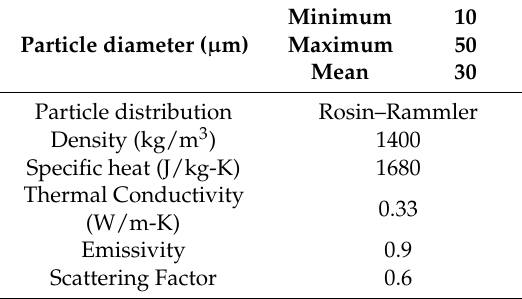
Table 5. Properties of coal